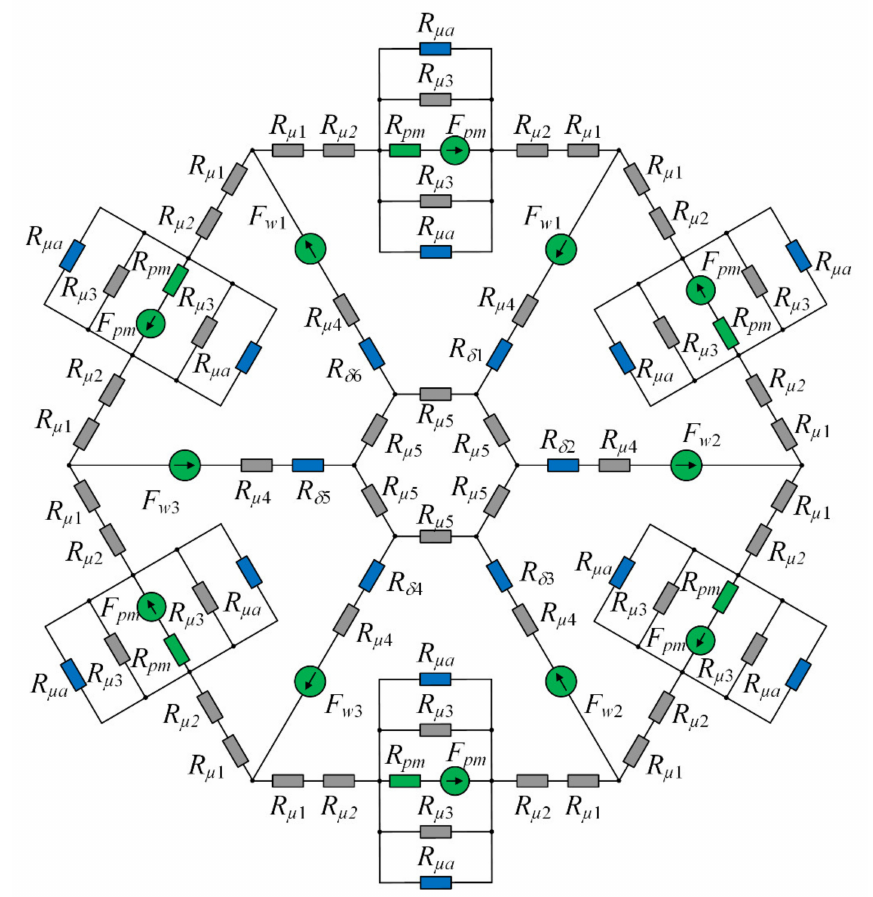
Figure 4. The magnetic equivalent circuit of the